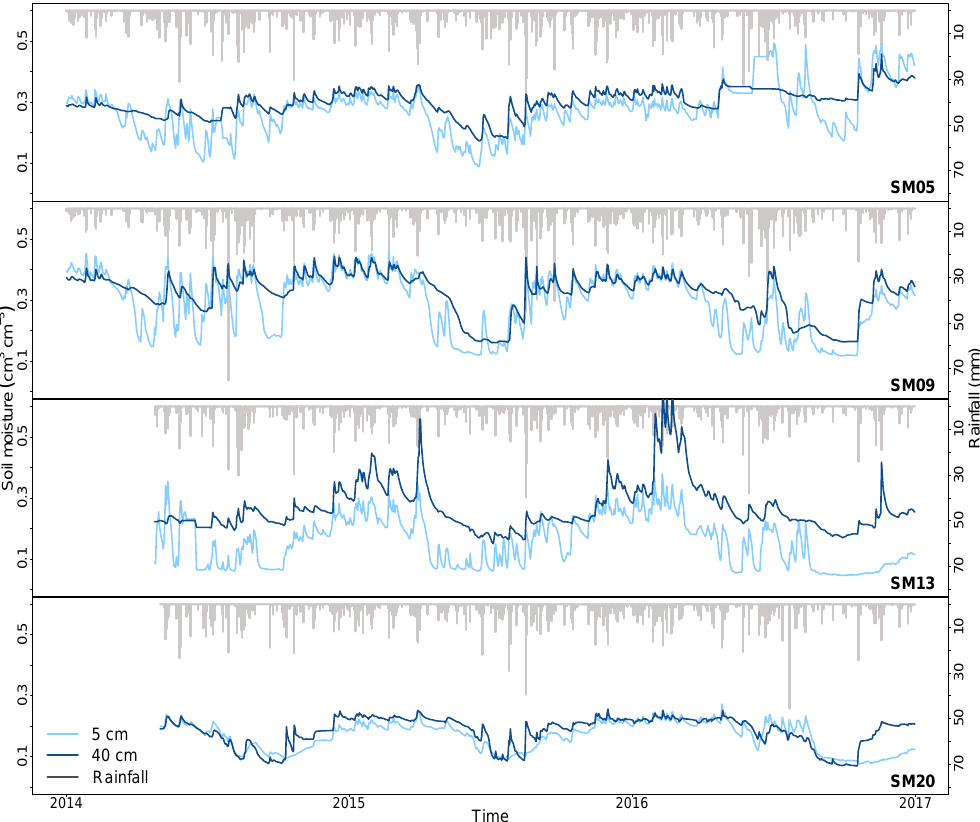
Figure 2. Time series plots of surface (5cm in light blue) and subsurface (40cm in dark blue) soil moisture. Vertical black bars at the top show daily precipitation data from the nearest KNMI station.